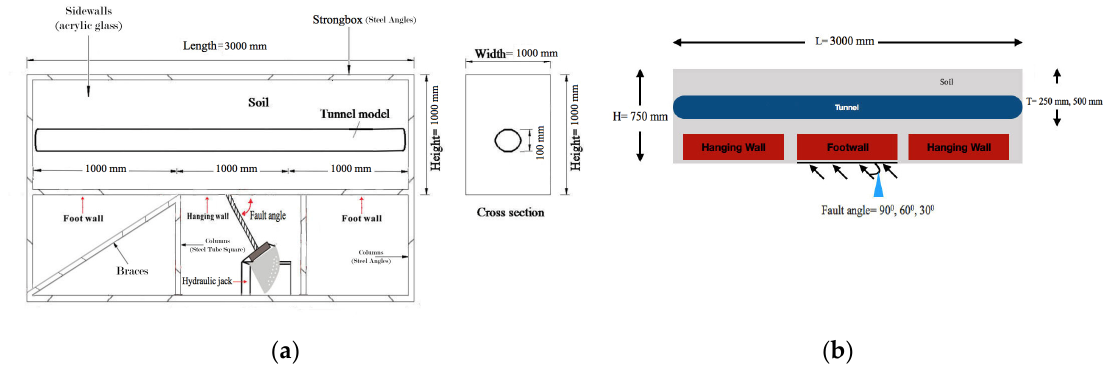
Figure 1. Schematic of ( a ) physical model ( b ) strongbox.